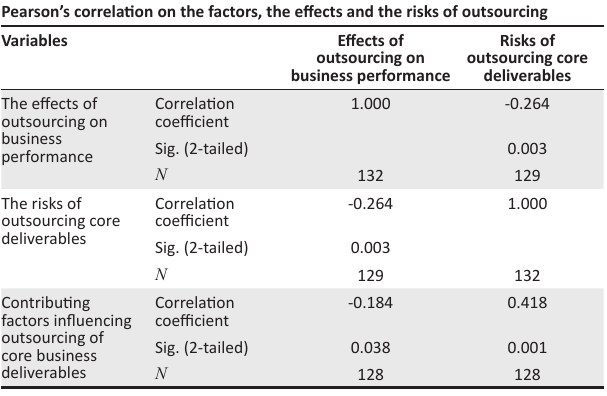
TABLE 7: Pearson’s correlation on the factors, the effects and the risks of outsourcing. Pearson’s correlation on the factors, the effects and the risks of outsourcing